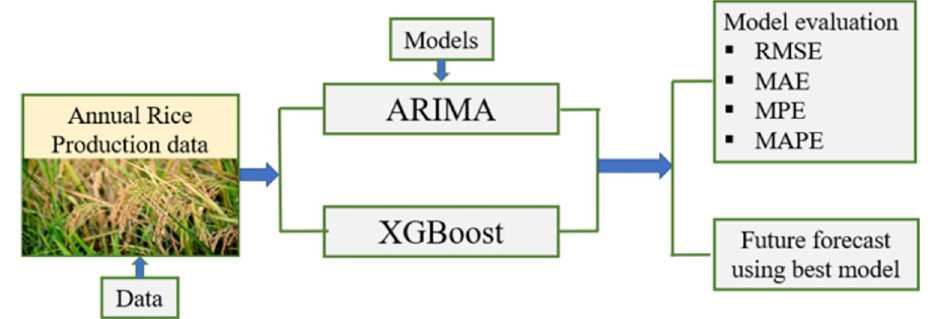
Fig 1. Theoretical framework for the